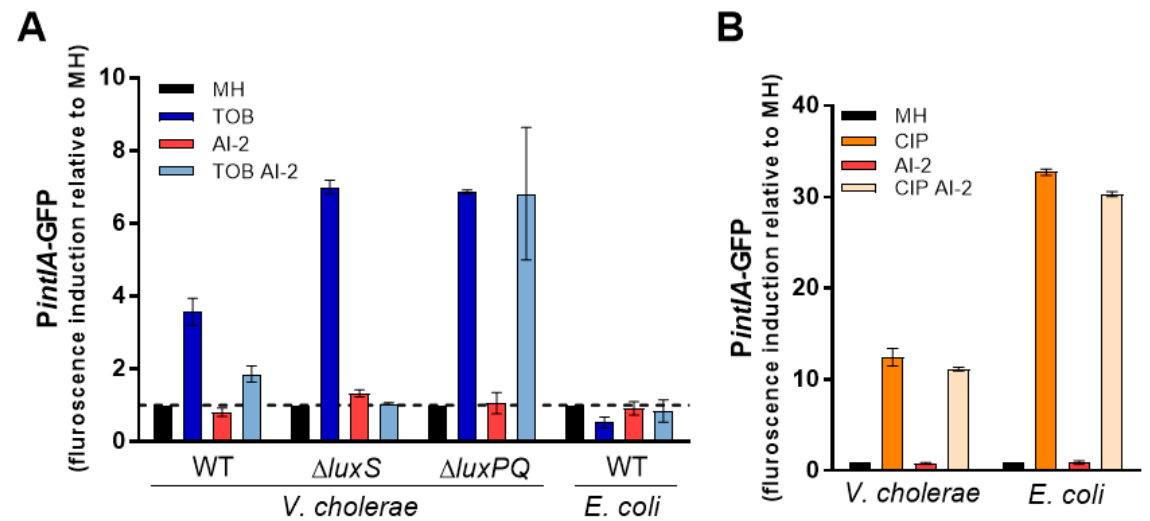
Figure 4. Aminoglycoside-mediated SOS induction in V. cholerae depends on LuxS/AI-2 signalling. SOS induction by ( A ) subMIC tobramycin (TOB, 0.02 µg/mL) or ( B ) subMIC ciprofloxacin (CIP, 0.005 µg/mL) in V. cholerae and E. coli cells.